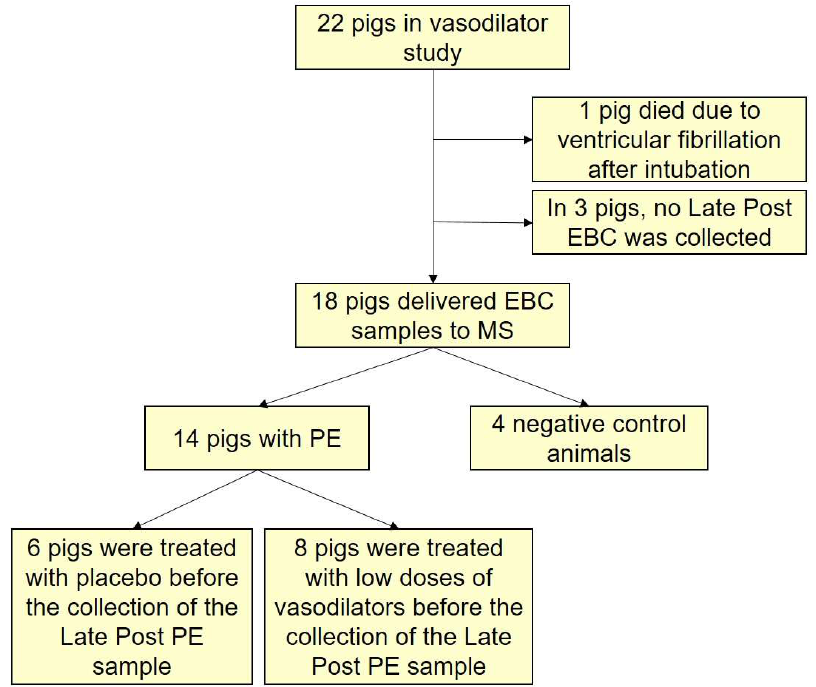
Figure 2. Overview of the study animals. Abbreviations: PE = pulmonary embolism, MS = mass spectrometry, EBC = exhaled breath condensate.